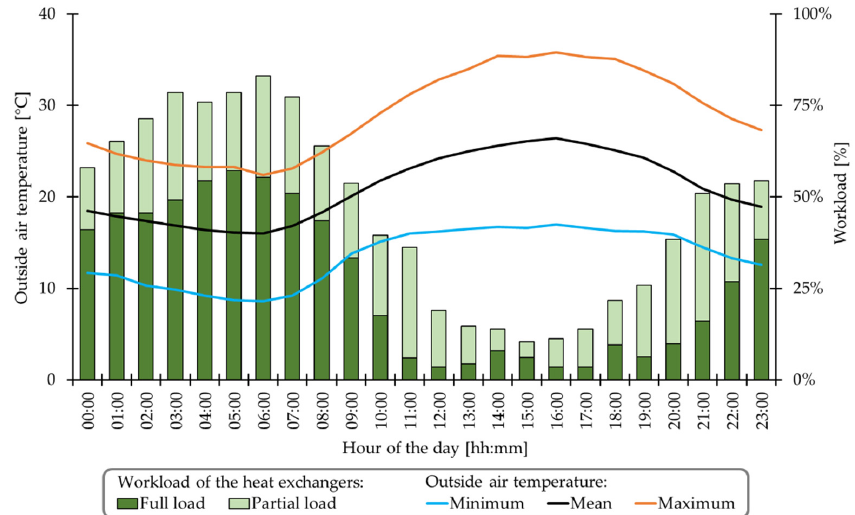
Figure 3. Workload of the heat exchangers (full or partial load) and outside air temperatures t 0 (minimum, maximum and mean values) in August 2020 concerning the mean values for the hours of the day (over the 31 days of the month).